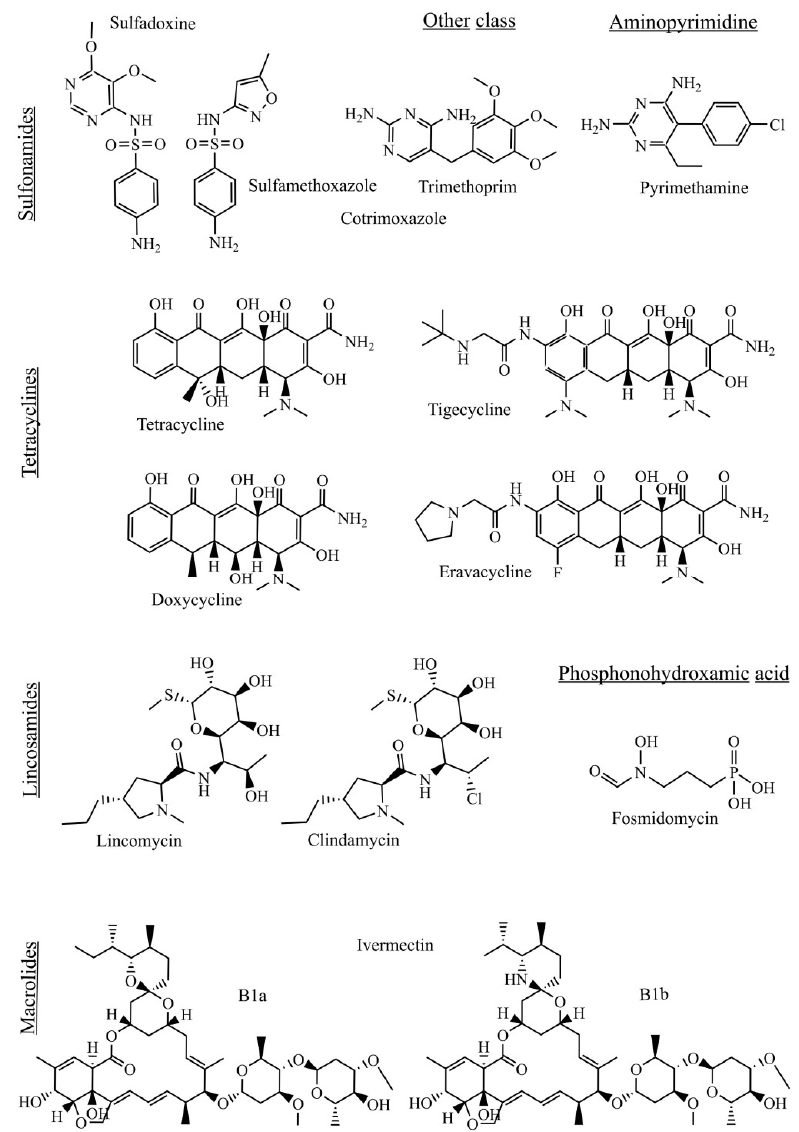
Figure 1. Antibiotics with potent antiplasmodial activity.